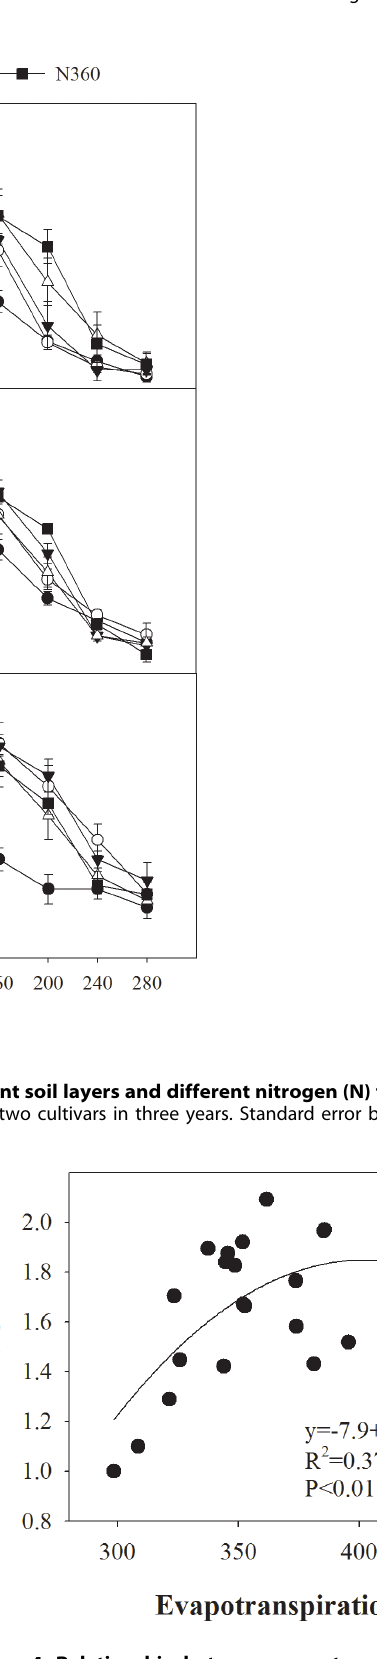
Figure 4. Relationship between evapotranspiration (ET) (mm) and WUE (Y) for winter wheat in northwest China. The relation between ET and WUE is shown by the equation.